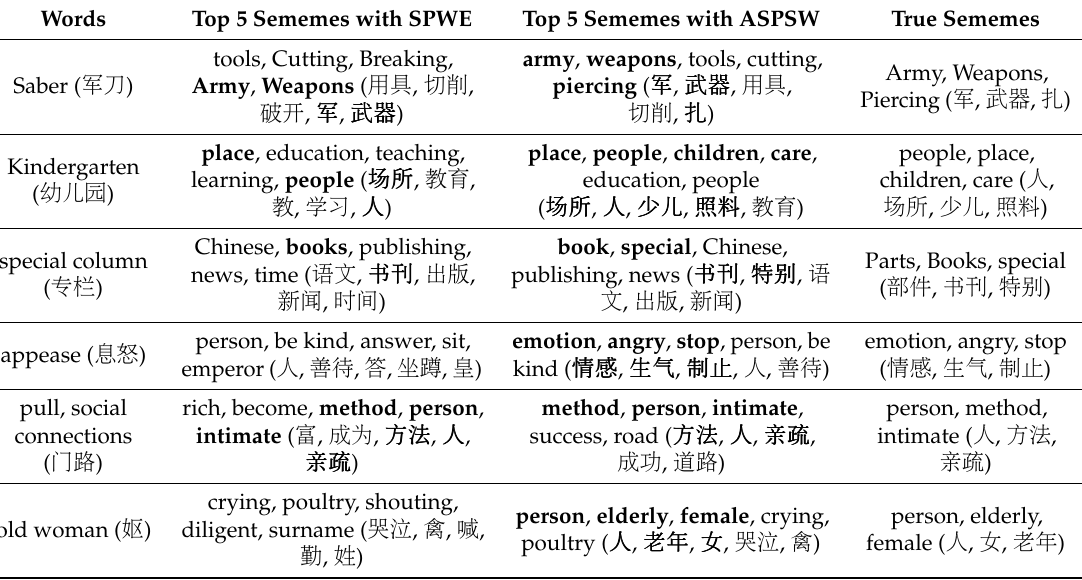
Table 6. Comparison of sememe prediction examples for the SPWE and ASPSW models, the sememes in bold font are the true sememes for each